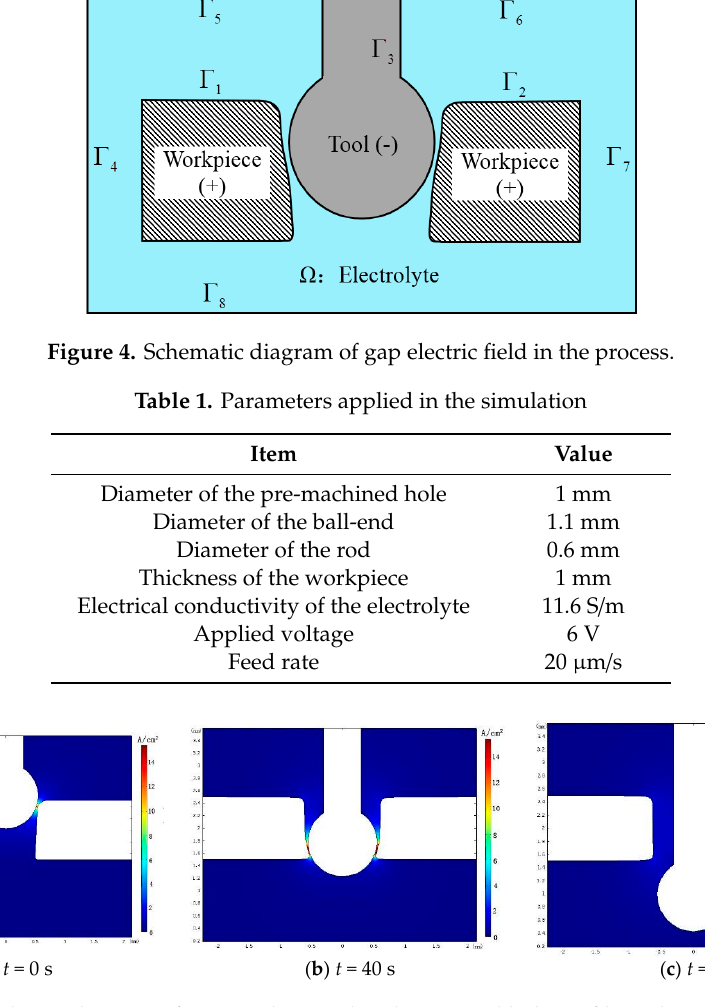
Figure 5. Simulation diagram of current density distribution and hole profile with UAECDG process.